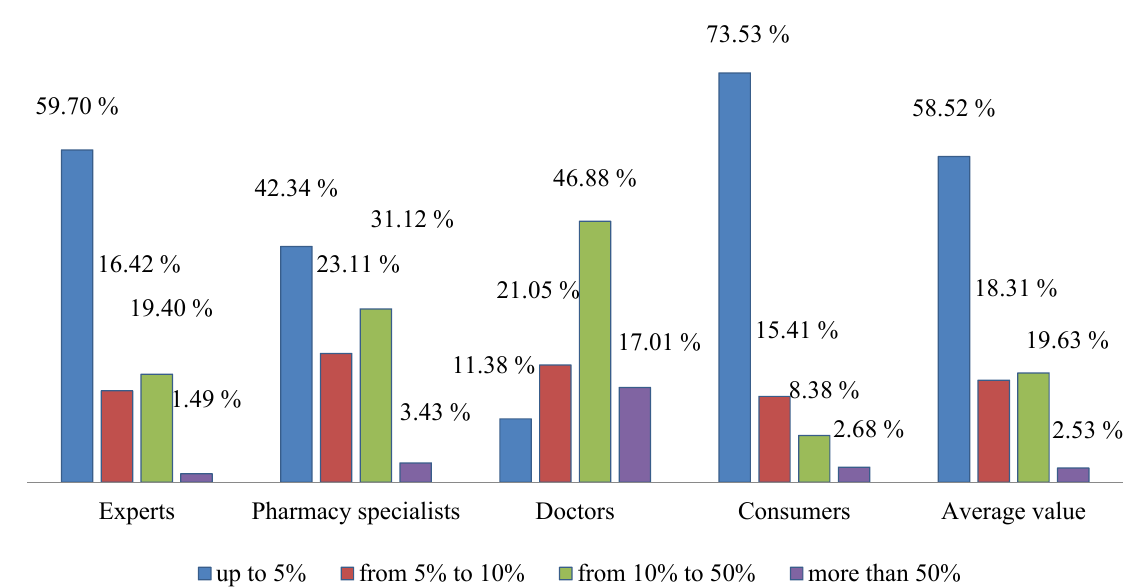
Fig. 1. Survey results on the share of counterfeit drugs in the pharmaceutical market of Ukraine